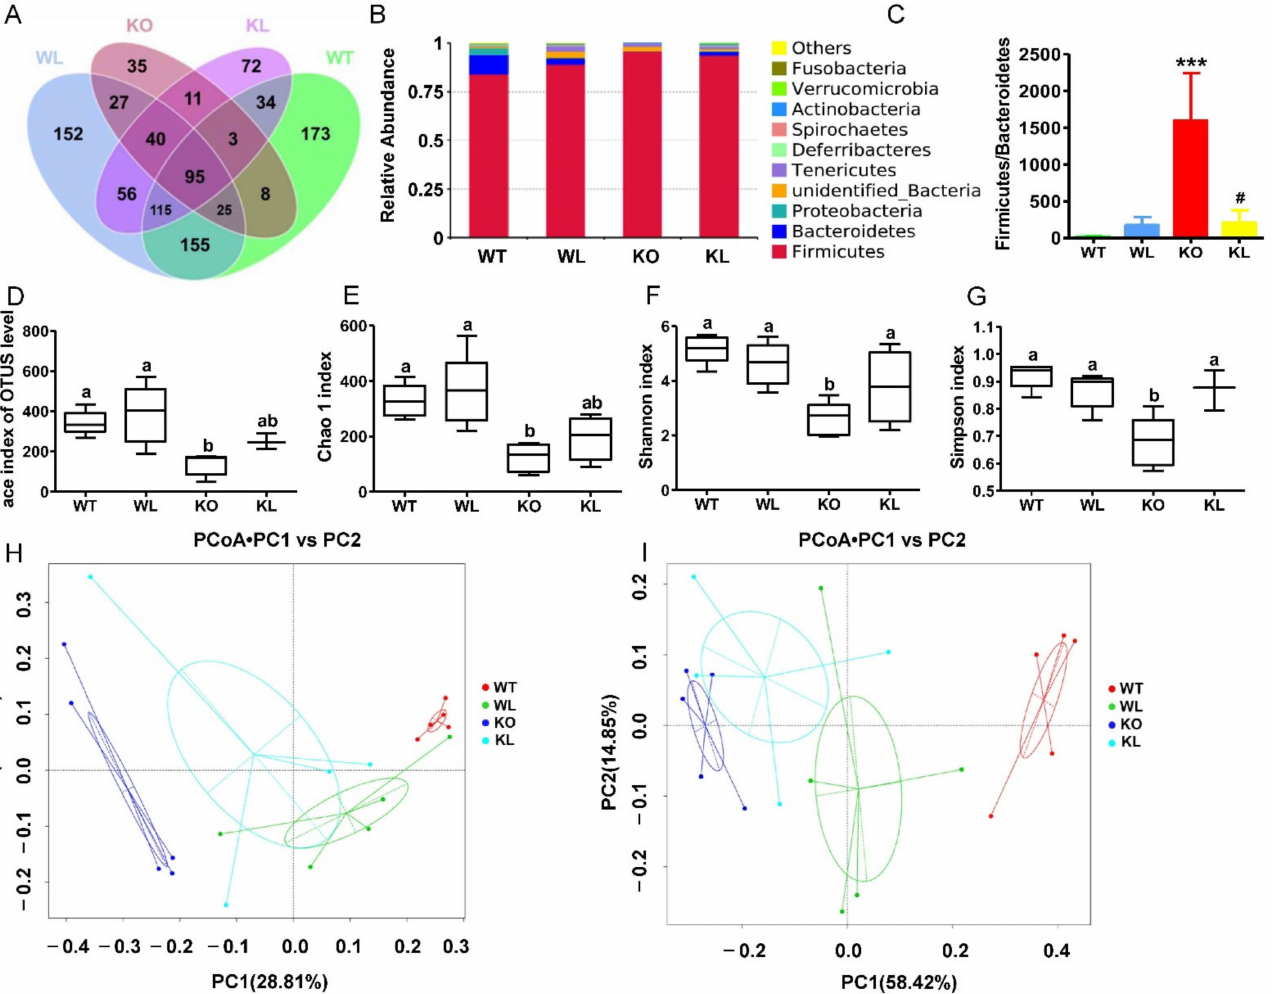
Figure 7. LWE altered the composition and increased the diversity of microbiota in Lepr − / − rats. ( A ) Venn diagram of gut microbiota in different group rats; ( B ) the abundance of the top 10 Phylum among the different group rats; ( C ) the ratio of relative abundance of Firmicutes to Bacteroidetes ; the alpha diversity of the gut microbiota with different indices: *** p < 0.001 when compared to WT group; # p < 0.05 when compared to KO group. ( D ) ace index, ( E ) Chao 1 index, ( F ) Shannon index, and ( G ) Simpson index; ( H ) Unweighted UniFrac PCoA (principal coordinates analysis) of gut microbiota; ( I ) Weighted UniFrac PCoA of gut microbiota. Values are means ± SEM (n = 4–5). Columns with different letters are significantly different ( p <